Question: Name the type of graph shown.
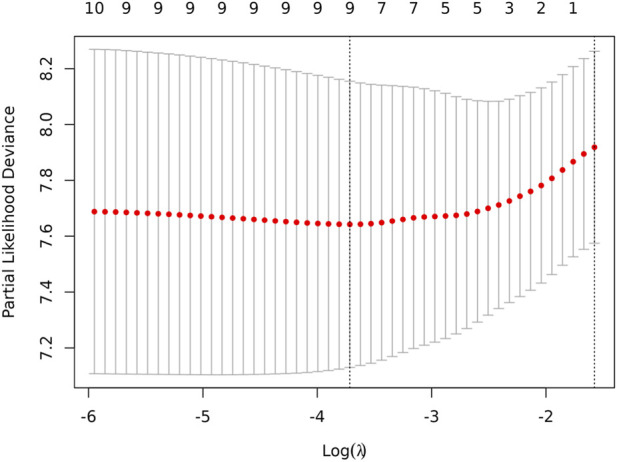
Answer: line